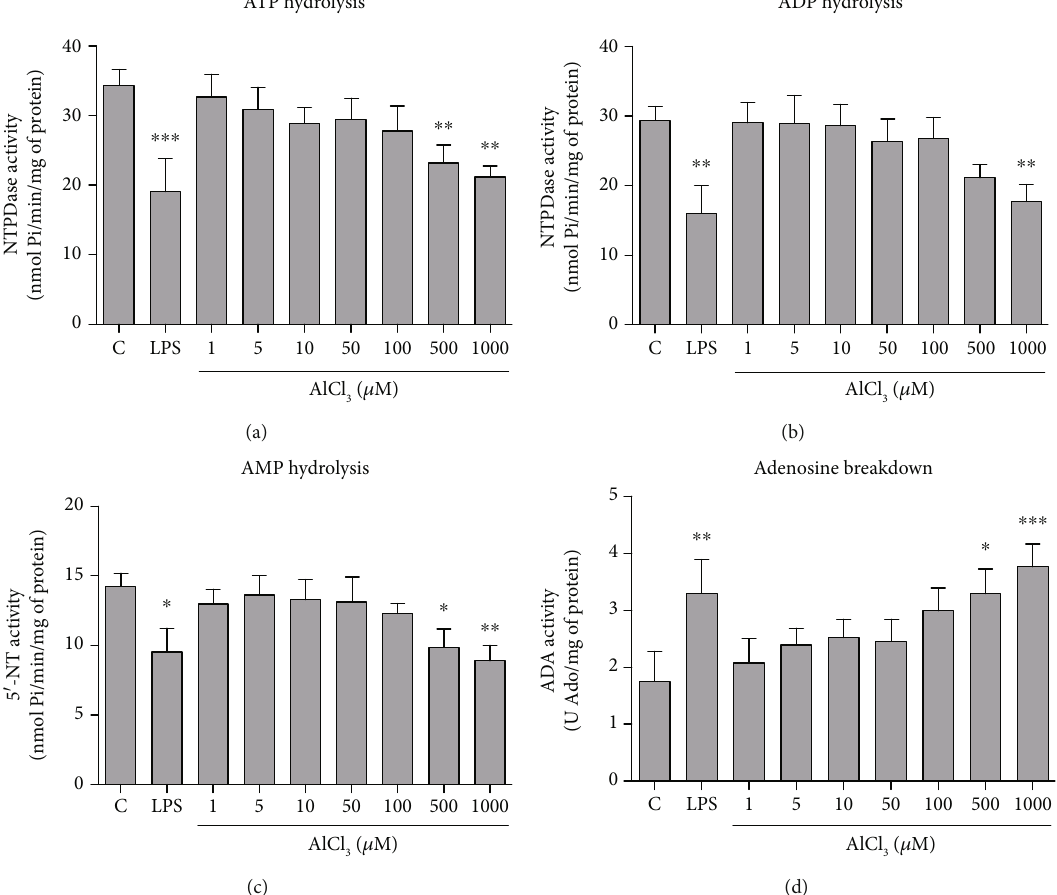
Figure 2: Purinergic enzyme activities of microglial cells treated with LPS (1 μ g/mL) and increasing concentrations of AlCl 96h. NTPDase activity using (a) ATP and (b) ADP as substrates, (c) 5 ′ -NT activity using AMP as substrate, (d) ADA activity using adenosine as substrate. C =control group; LPS=lipopolysaccharide. Values are expressed as mean ± SD ( n = 3 ). ∗ Statistical signi fi cance in comparison to the control group. ∗ p < 0 : 05 , ∗∗ p < 0 : 01 , and ∗∗∗ p < 0 : 001 . One-way ANOVA followed by Tukey ’ s post hoc